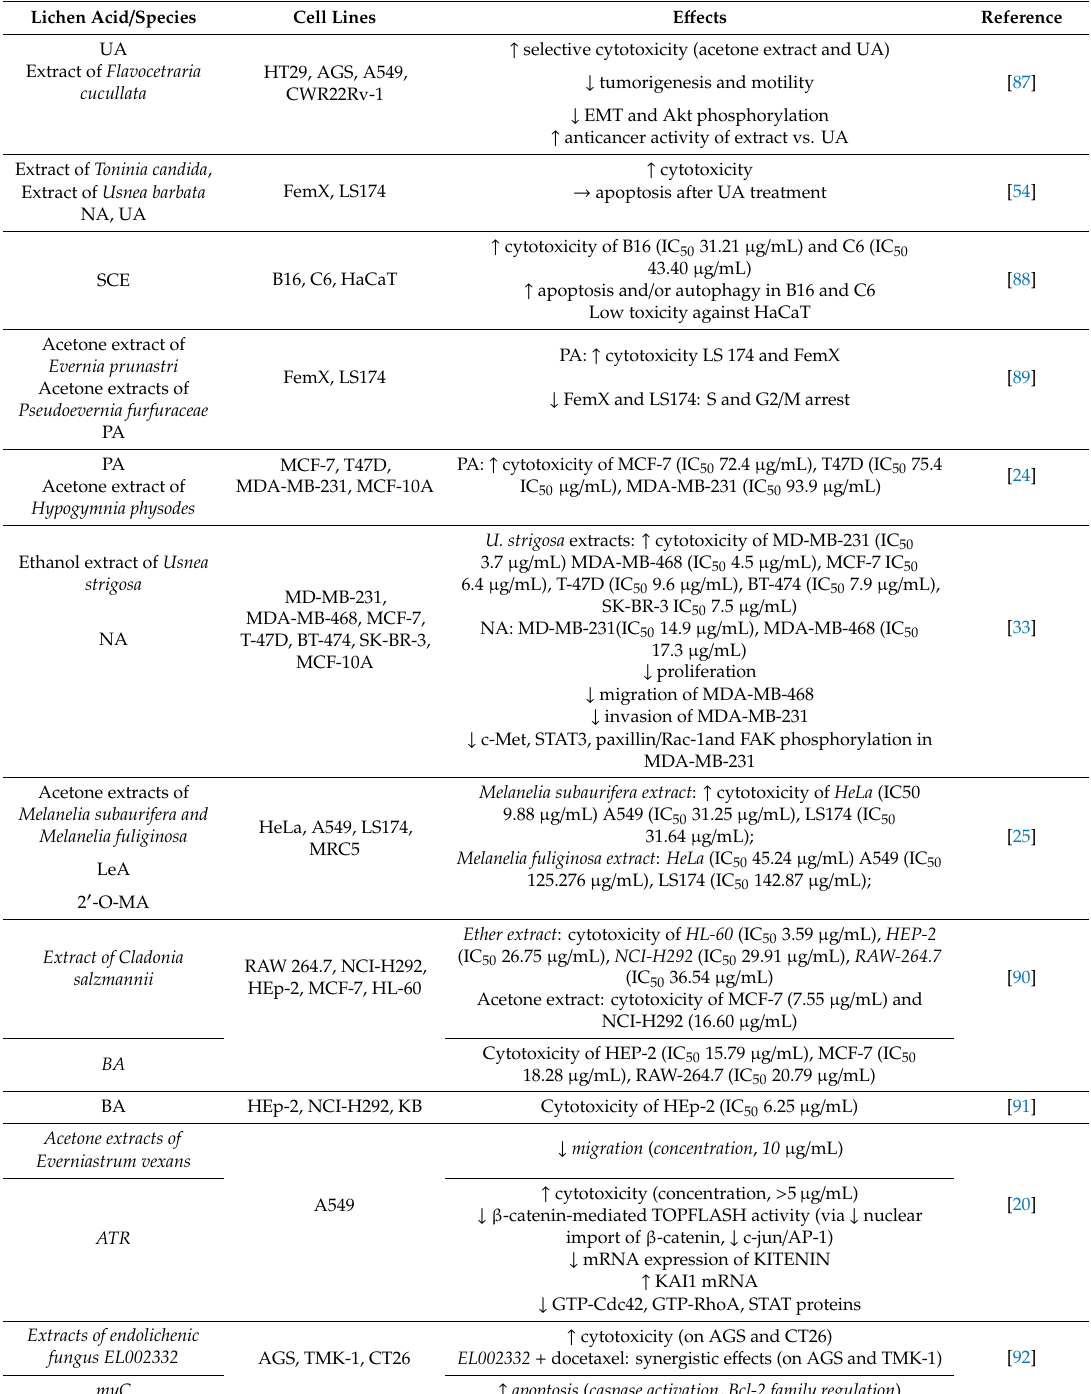
Table 3. An overview of anticancer e ffi cacy of isolated lichen compounds in combination with lichen